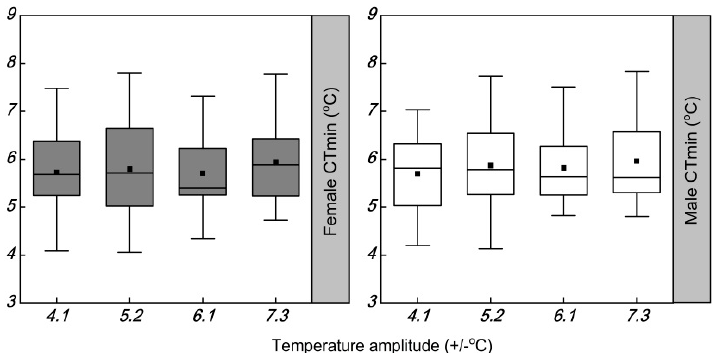
Figure 5. Box plot of the cold coma temperature (CT min ) of females and males of Plutella xylostella developed under four daily temperature amplitudes, with a similar mean temperature. The upper and lower boundaries of the box indicate the 75th percentile and 25th percentile of the data set, respectively. The black horizontal line and black square within the box represent the median and mean values, respectively. Error bars above and below the box indicate the minimum and maximum values, respectively. Different letters above each box indicate significant differences ( p < 0.05) among the treatments.